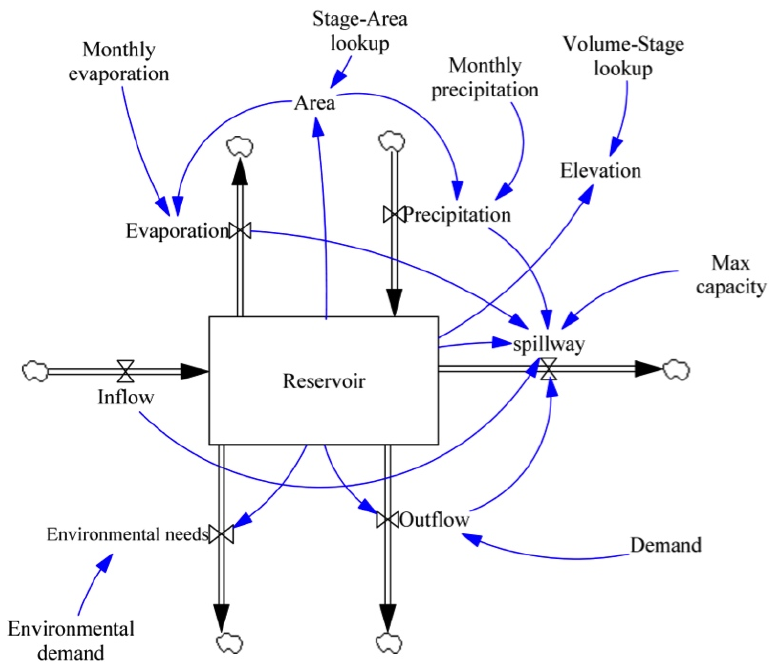
Figure 1. System dynamics model of the surface water reservoir